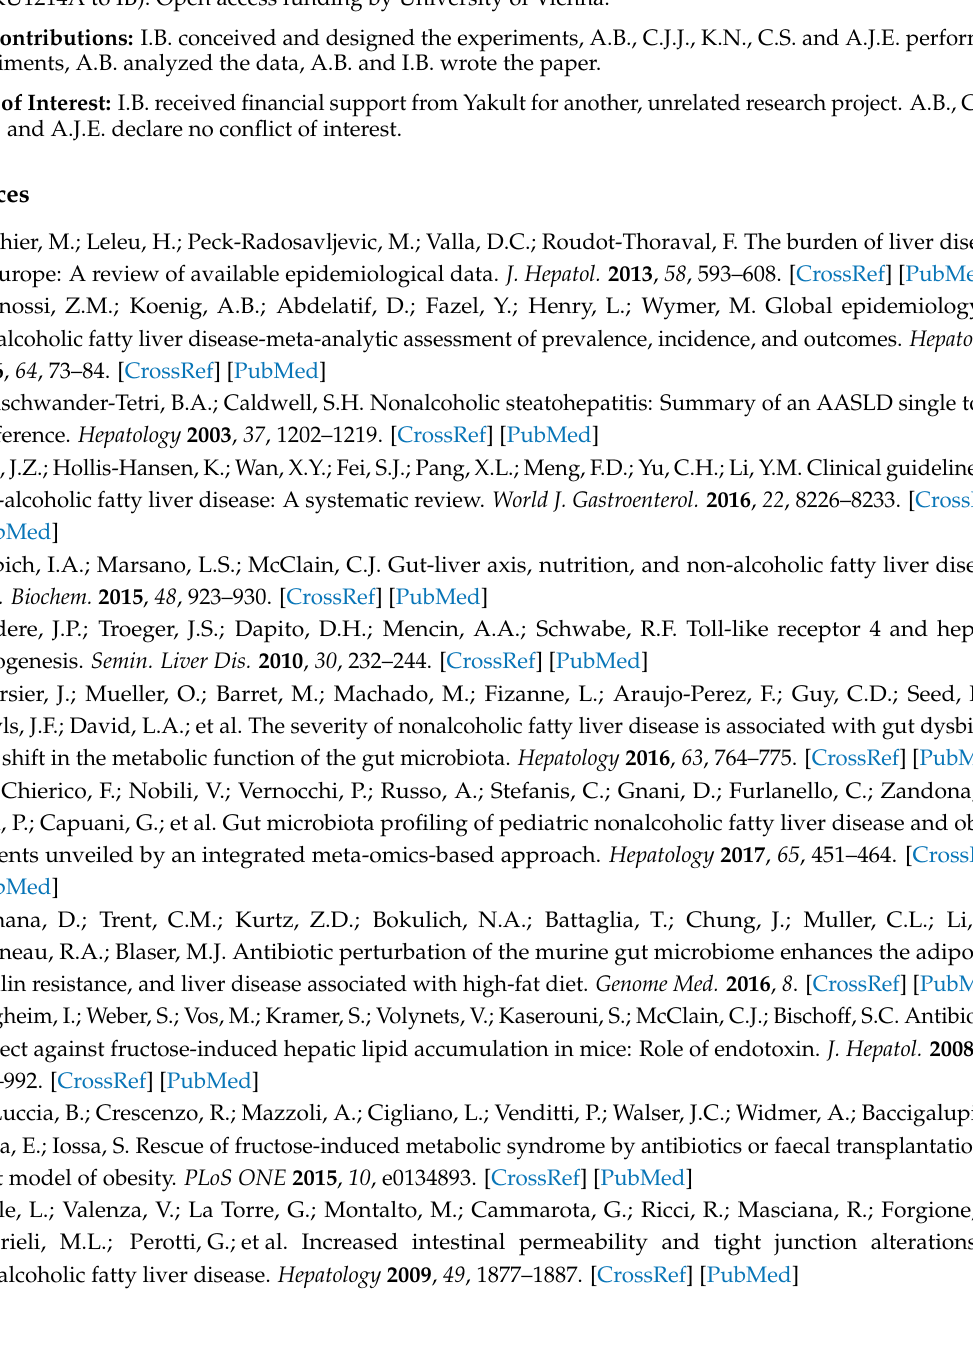
Table S1: Nutrient composition of control diet and fat-, fructose- and cholesterol-rich diet (FFC) (both Ssniff, Germany), Figure S1: Effect of a short-term feeding of a FFC or control diet ± oral antibiotic treatment on different tight junction proteins and MMPs in small